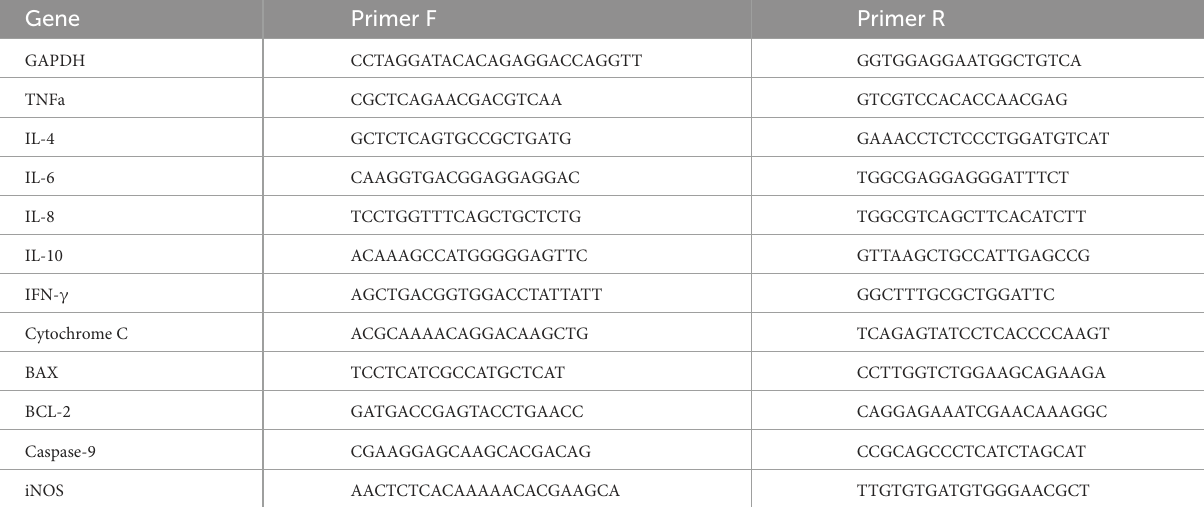
TABLE 1 List of primers tested for relative gene expression.